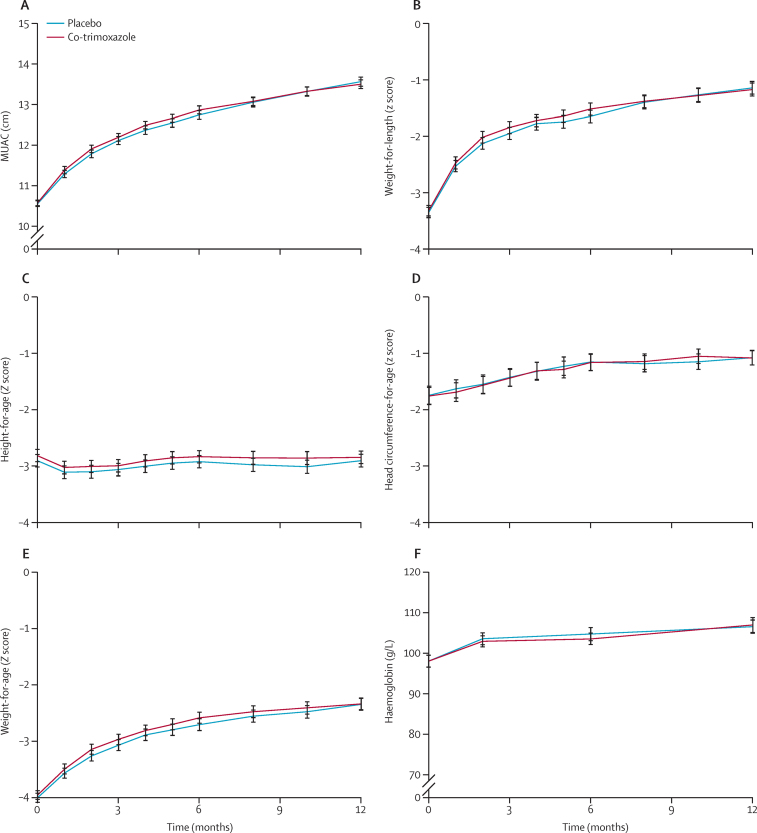
Anthropometry during follow-upData are means; error bars indicate 95% CI. No individual timepoint comparisons between randomised groups were significant (appendix). MUAC=mid-upper-arm circumference.